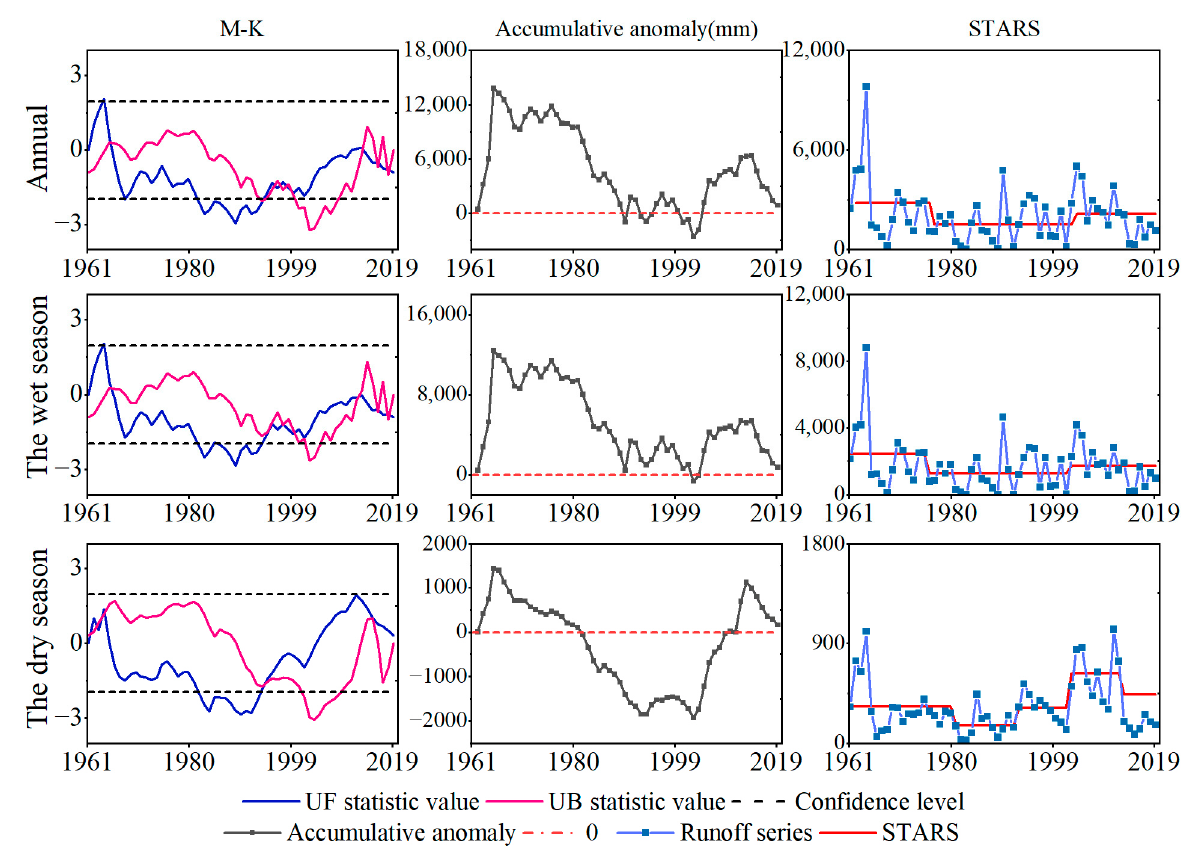
Figure 9. The mutation analysis of the runoff at Daicunba station.